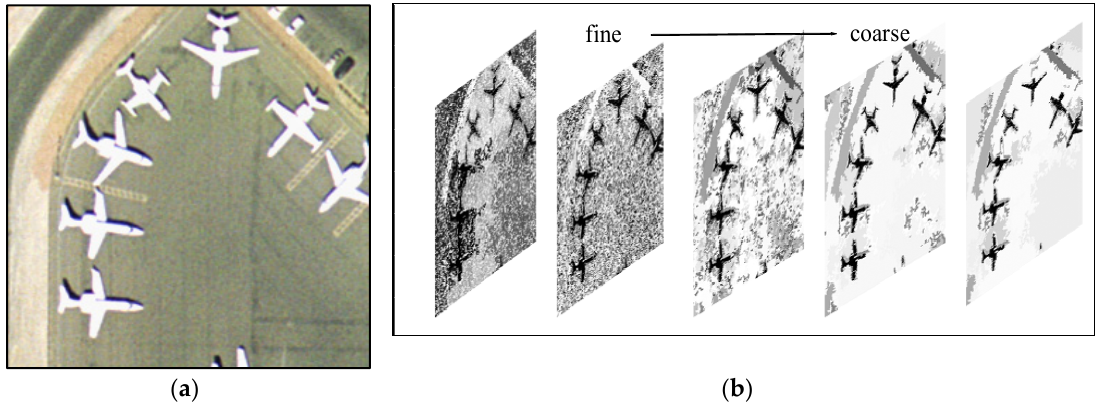
Figure 3. The segmentation of the HRS image via Color Binary Partition Tree (CBPT) ( a ) An HRS airport image; ( b ) Segmentation results at multiple scales.